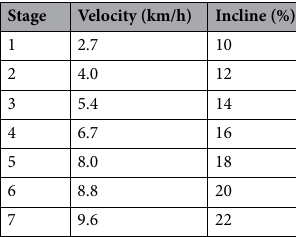
Table 1. Treadmill test